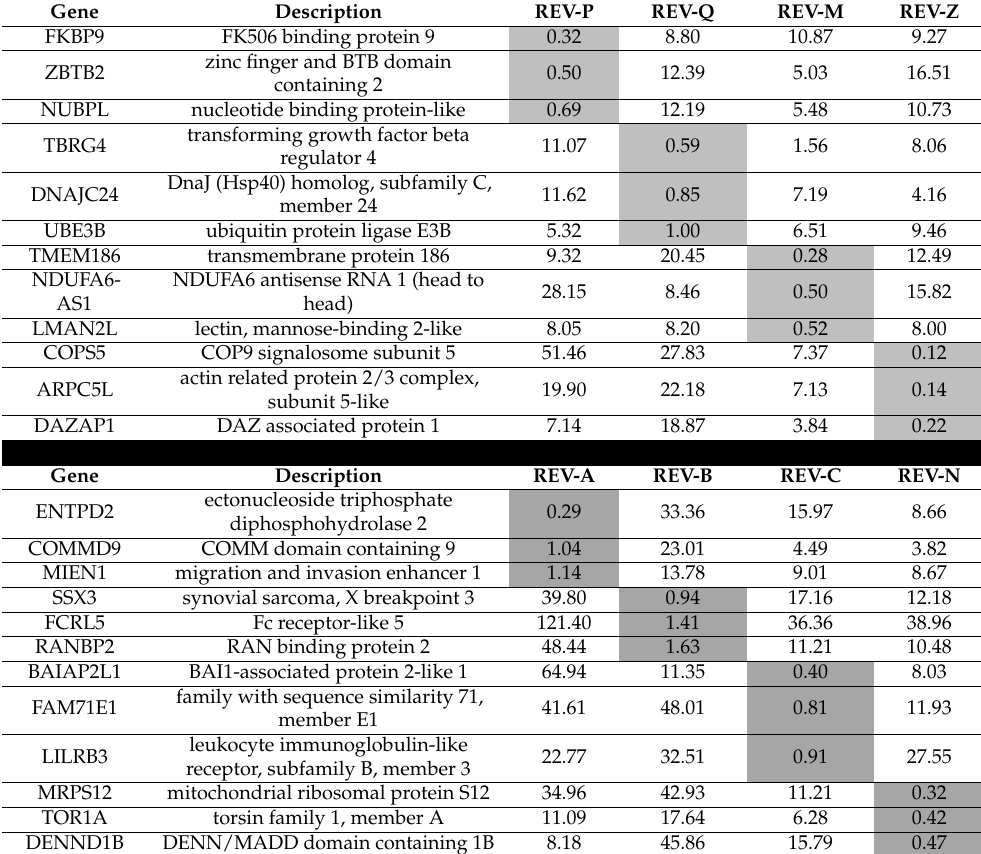
Table 2. Three most stably (low REV, darker gray background) expressed genes in each of the four profiled regions of patients “PQMZ” and